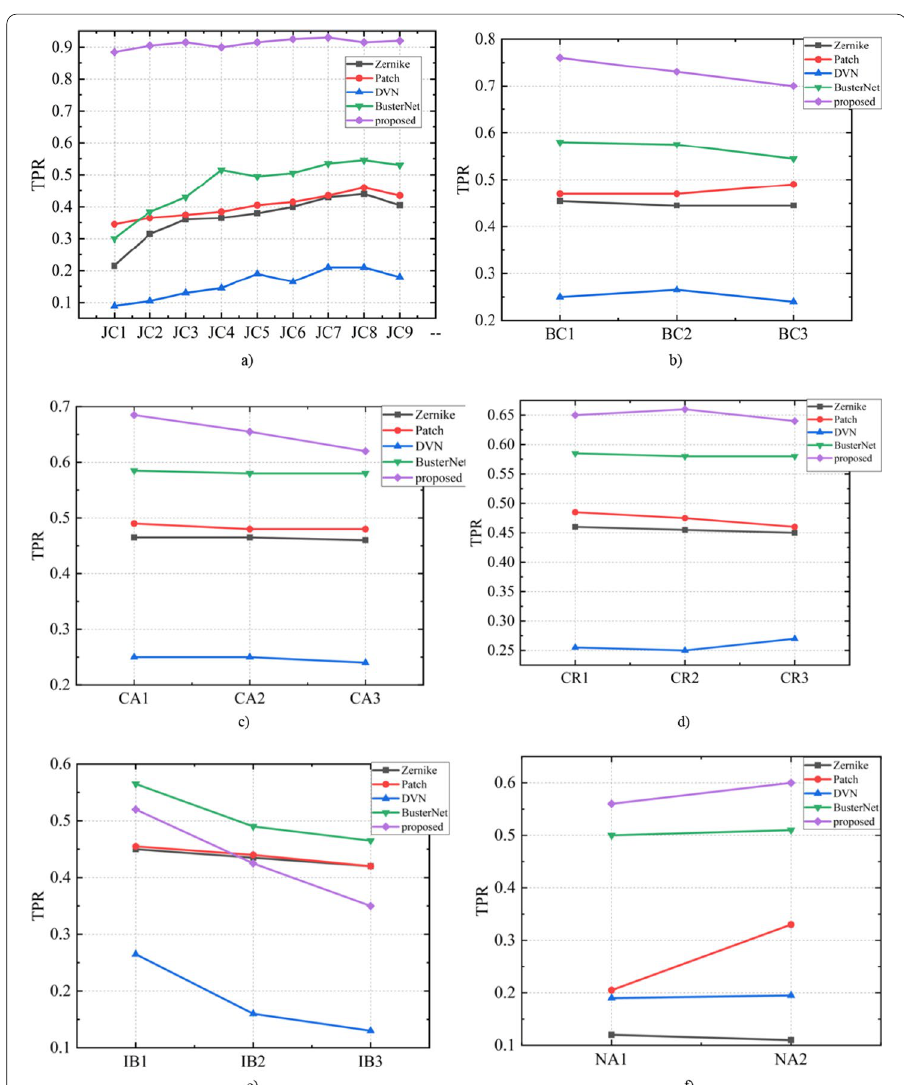
Fig. 12 Robustness comparison of different methods for different attack types. a JPEG attack, b brightness change, c contrast change, d color change, e fuzzy attack, f noise